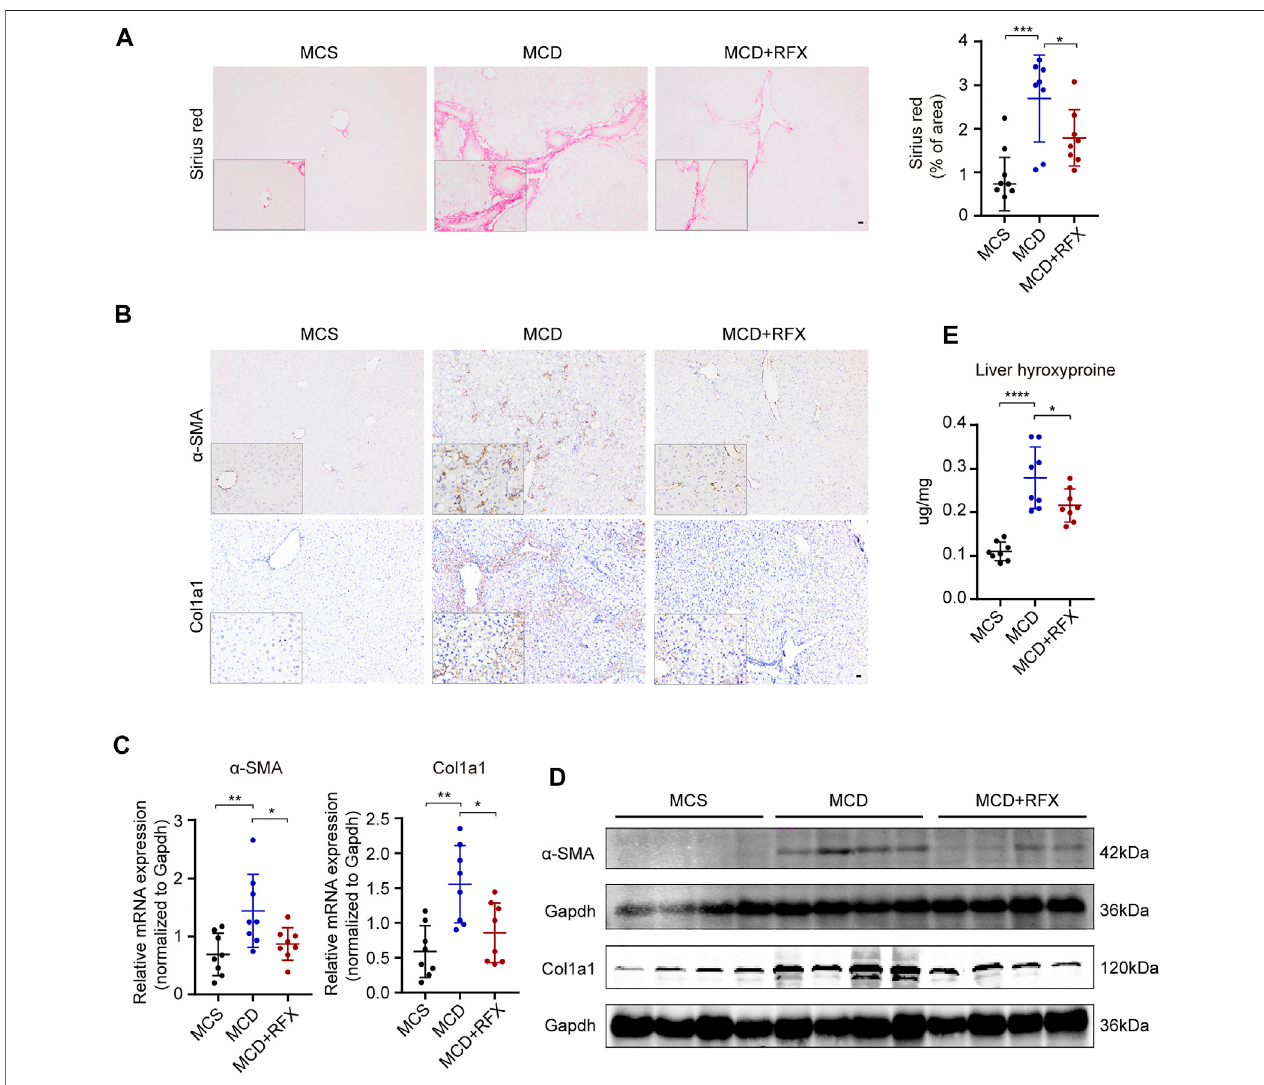
FIGURE 2 | Rifaximin treatment alleviates MCD diet-induced hepatic fi brosis in mice. (A) Representative images of paraf fi n-embedded liver sections stained with Sirius Red (left panel) and semiquantitative analysis of Sirius Red staining positive area in mouse liver tissues (right panel). Scale bars = 200 µm. (B) Representative images of α -SMA and Col1a1 immunostaining. Scale bars = 200 µm. (C) qRT-PCR analysis of Acta2 and Col1a1 mRNA levels in mouse livers. Gapdh is for normalization. (D) Representative western blot analysis of α -SMA and Col1a1 in mouse livers. (E) Hydroxyproline content in mouse livers. Data are expressed as mean ± standard deviation. For A, C, E: * p < 0.05, ** p < 0.01, *** p < 0.001, **** p < 0.0001 ( p value was determined by one-way ANOVA). n = 8 mice per group.